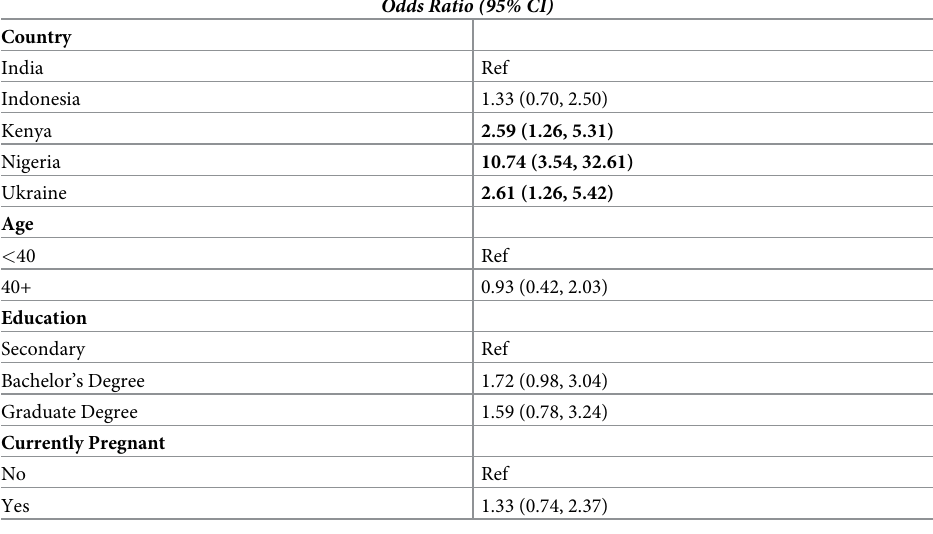
Table 4. Odds ratios of vaccine hesitancy status by pregnant participant characteristics using logistic regression modeling (n = 441) �